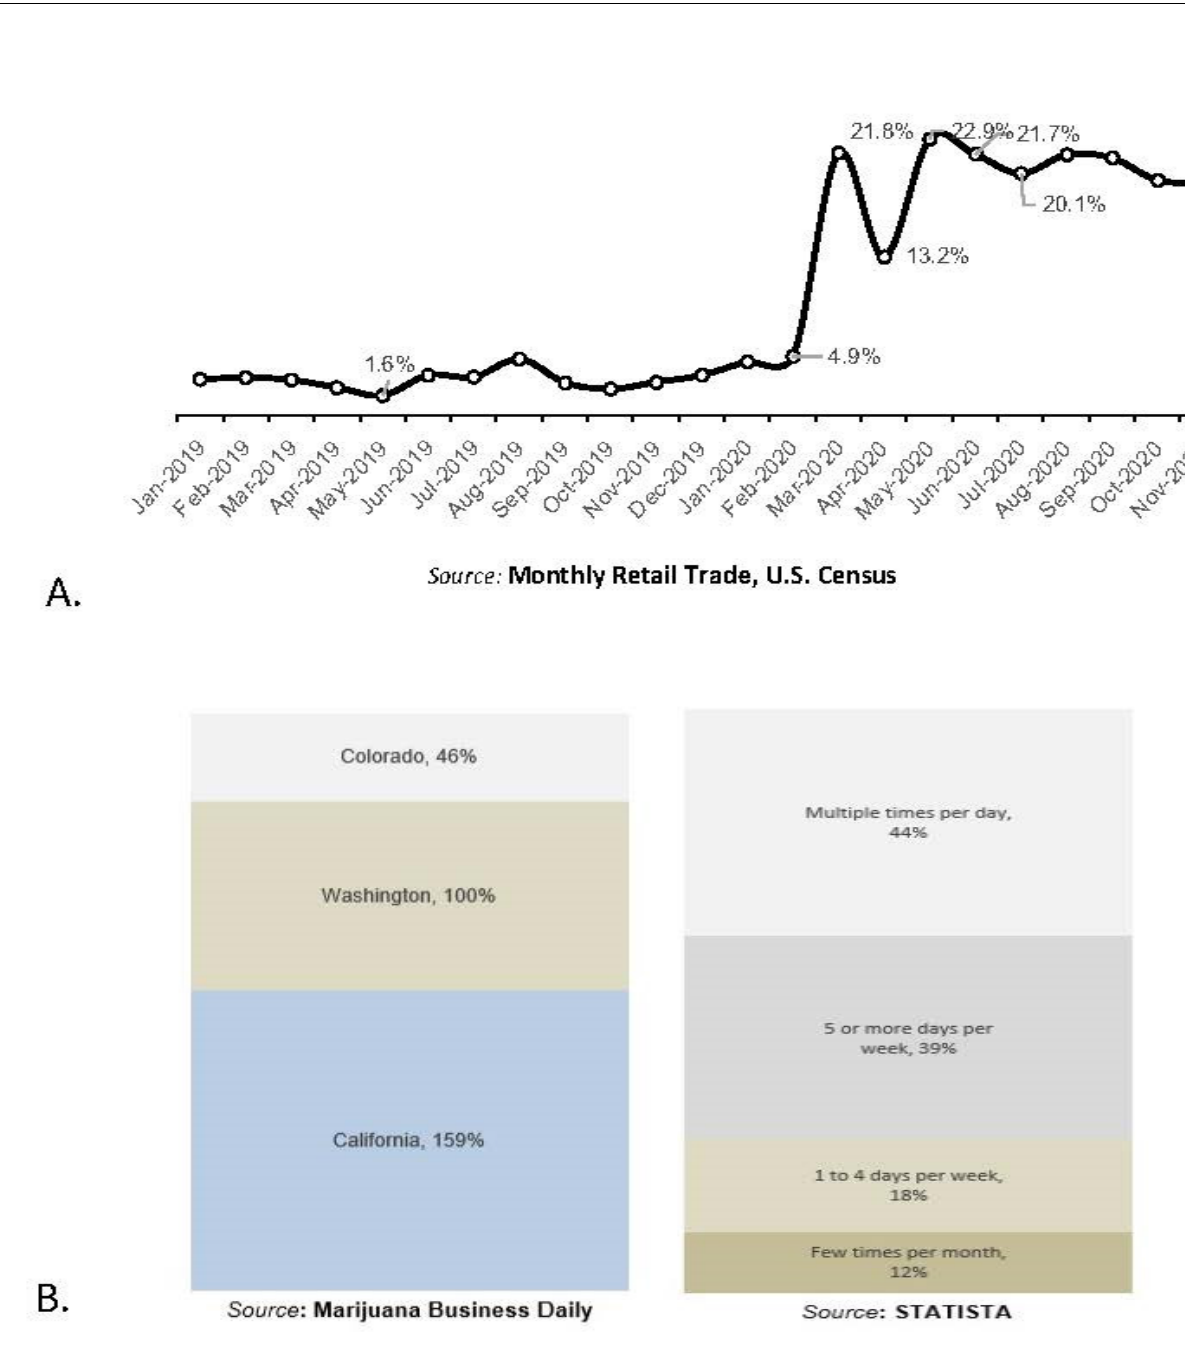
Figure 3. ( A ): The Monthly Retail Trade statistics data. Data are published by the U.S. Census (https://www.census.gov/retail/index.html#mrts (accessed on 1 March 2021)) and analyzed for the period 1 January 2019–1 November 2020. The U.S. Census reports the data as the ‘Advanced Monthly Sales for Retail Trade’, released monthly and seasonally adjusted. Panic-buying demonstrated by “Sales growth = [0.004]ˆ(**) + [0.17]ˆ* dummy; adj_(Rˆ2) = 0.95”. Significance levels are reported as alpha 1, 5, and 10%. At 1% level of significance, confidence level is 99%. At 5% significance, confidence level is 95%. ( B ): Data obtained for Colorado, Washington, and California. See the link: (https://mjbizdaily.com/recreational-cannabis- retailers-sales-surge-during-coronavirus-pandemic/ (accessed on 1 March 2021). Data obtained from STATISA.com, based on analysis from Brightfield Group. See the link: